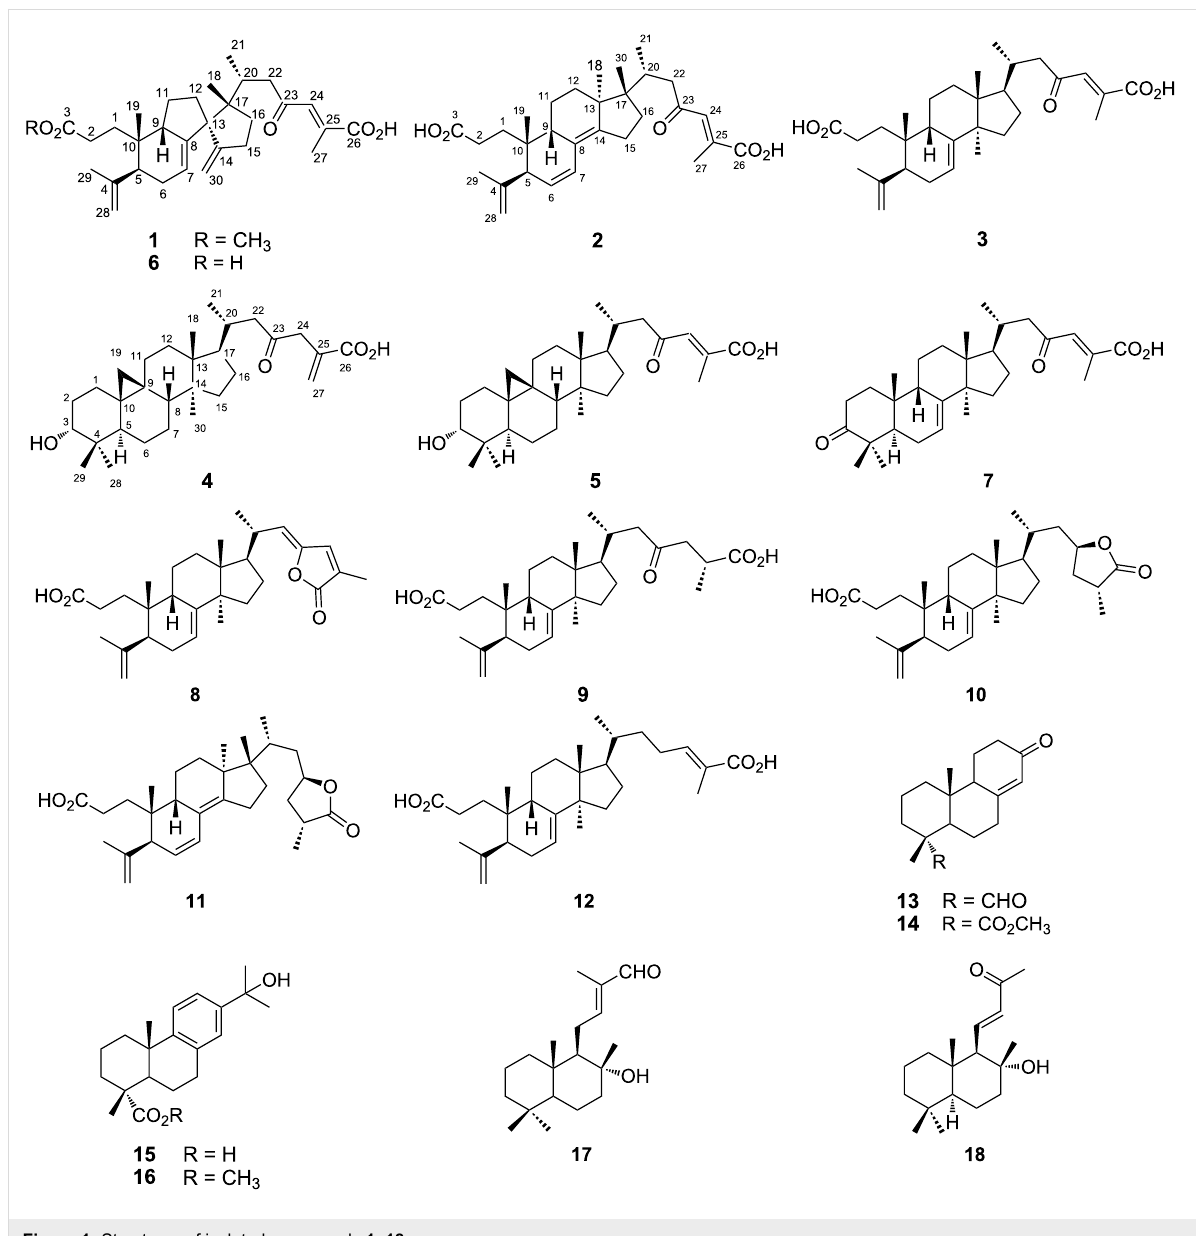
Figure 1: Structures of isolated compounds 1 – 18